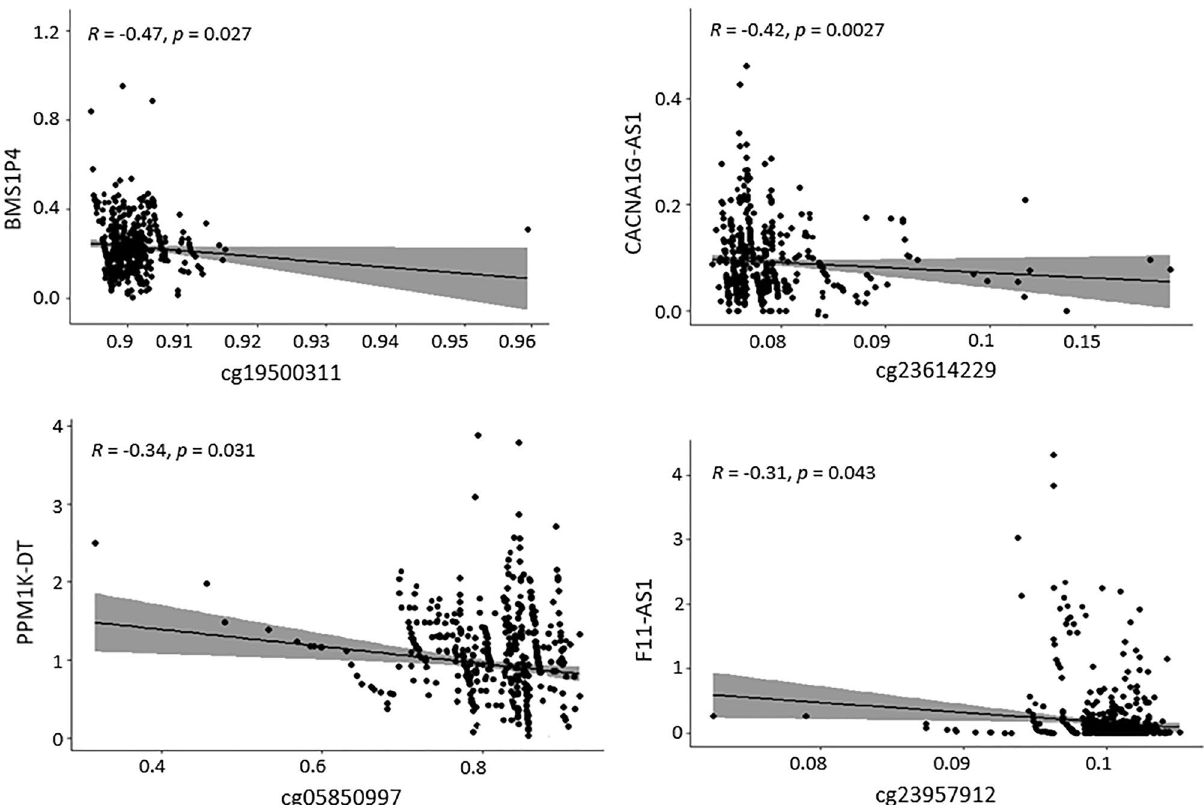
Figure 3. Correlation between the DMCs (cg19500311, cg23614229, cg05850997, and cg23957912) and the expression of lncRNAs (BMS1P4, CACNA1G-AS1, PPM1K-DT, and F11-AS1) in matched samples. The beta values of the DMCs are depicted in X-axis and the expression (FPKM) values of lncRNAs are depicted in Y-axis. R and p indicate the Spearman’s correlation coefficient and the p-values derived from Spearman’s correlation,